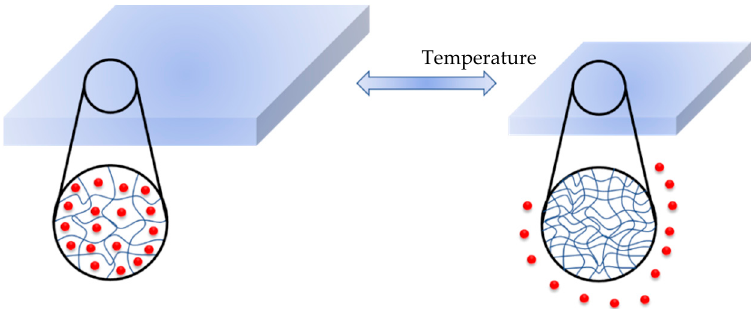
Figure 12. Shrink–swell behavior of a thermo-responsive hydrogel upon exposure to temperature. During the hydrogel shrinkage, the loaded drug is irreversibly released from the polymeric system. Adapted from [90]